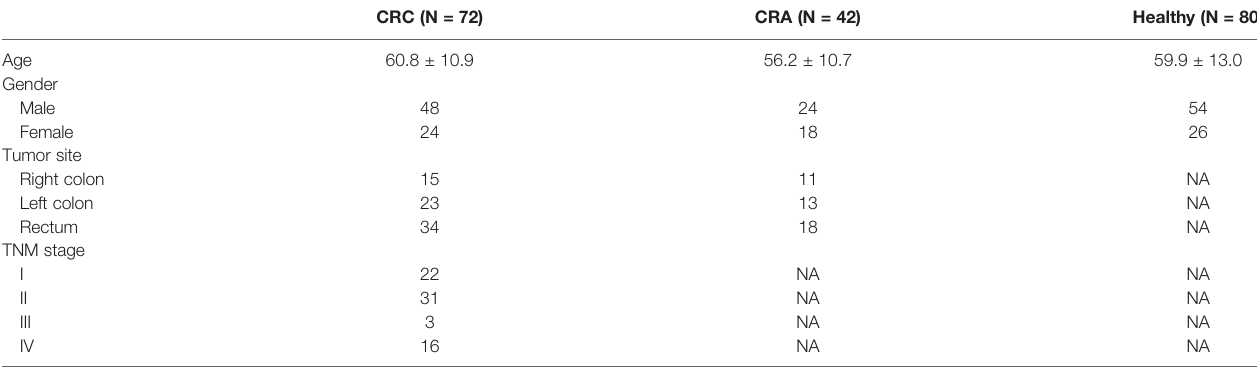
TABLE 1 | Clinicopathological information of 194